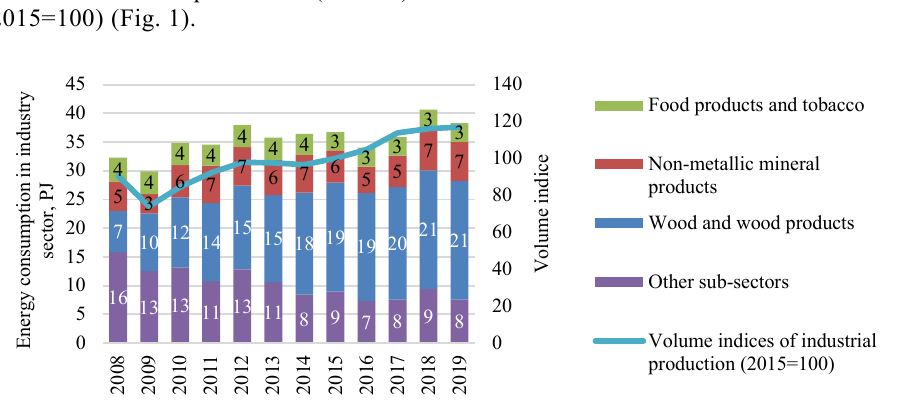
Fig. 1. Industrial production index [25] and final energy consumption [26] in Latvia’s industry sector from 2008 to 2019. Three main sub-sectors covering around 80 % of energy consumption in 2019 are wood and wood products (wood), non-metallic mineral products (minerals) and food products and tobacco (food). Total energy consumption has increased by around 20 % in 2019 compared to 2008 while energy consumption in the wood and wood products sub-sector has increased around three times but in the minerals sub-sector by circa 37 %. In the food sub-sector, energy consumption has decreased by 24 % and in other sub-sectors by 52 % in the respective